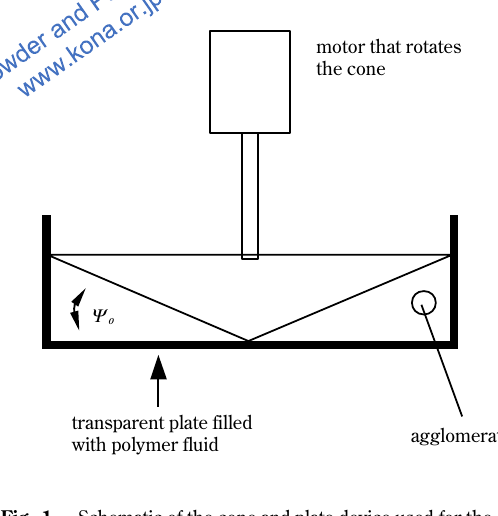
Schematic of the cone-and-plate device used for the steady- shear experiments. Cone angle Ψ o (cid:4) 4°; maximum gap between cone and plate (cid:4)(cid:3) 4 mm